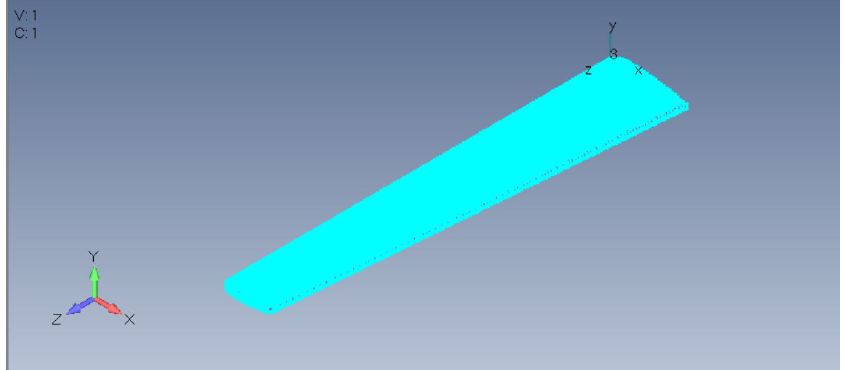
Figure 9. Base Wing splines connecting the Aerodynamic and Structural Grids.